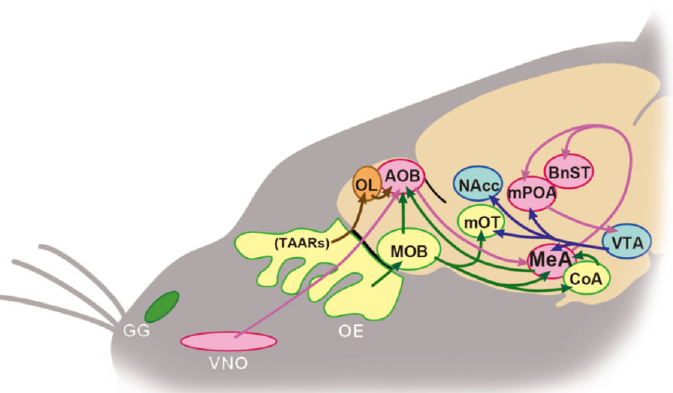
Figure 5. Schematic diagram of supposed chemosignals that modulate preference for opposite sex in mice. Red, green, brown, and blue arrows represent vomeronasal, main olfactory epithelial, TAARs, and DA rewarding signal streams, respectively. OE: olfactory epithelium, VNO: vomeronasal organ, GG: Grueneberg ganglion, TAAR: trace amine-associated receptor, MOB: main olfactory bulb, AOB: accessory olfactory bulb, OL: olfactory limbus, mOT: medial olfactory tubercle, CoA: cortical nucleus of amygdala, MeA, medial nucleus of amygdala, BnST: bed nucleus of stria terminalis, mPOA: medial preoptic area, VTA: ventral tegmental area, NAcc: nucleus